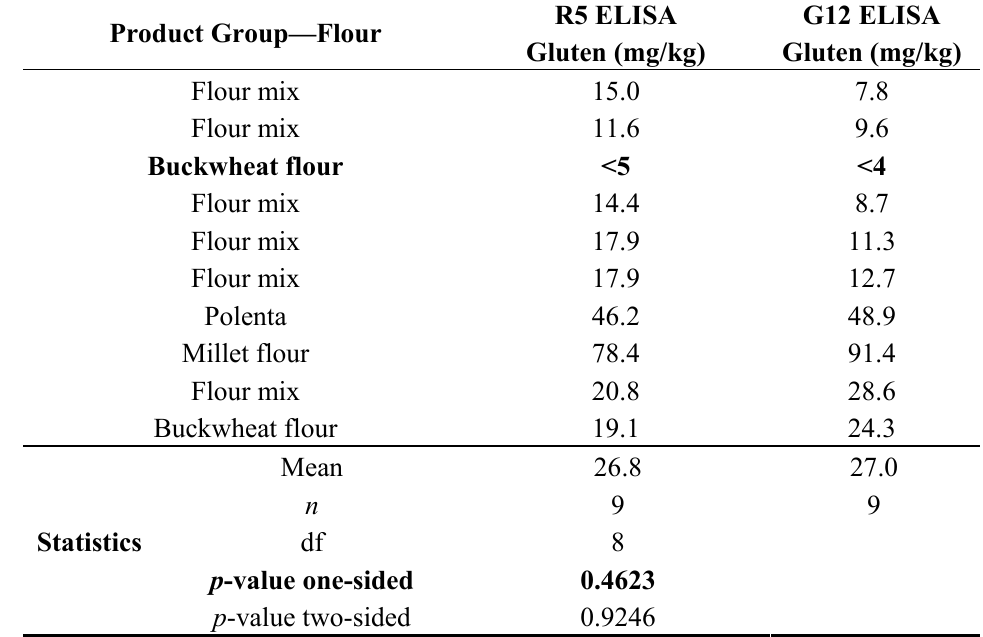
Table 3. Results of the flour product group: The buckwheat flour sample (highlighted in bold), which produced results below the LOQ for both methods, was excluded from the statistical analysis ( n = number of samples, df = degrees of